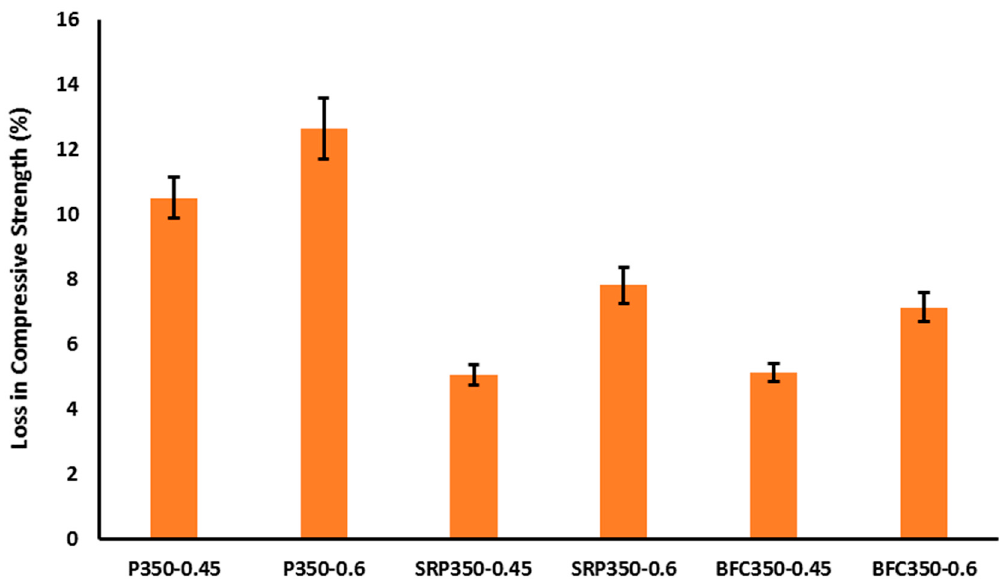
Figure 5. Strength loss of “medium strength concrete” class after sulfate exposure.